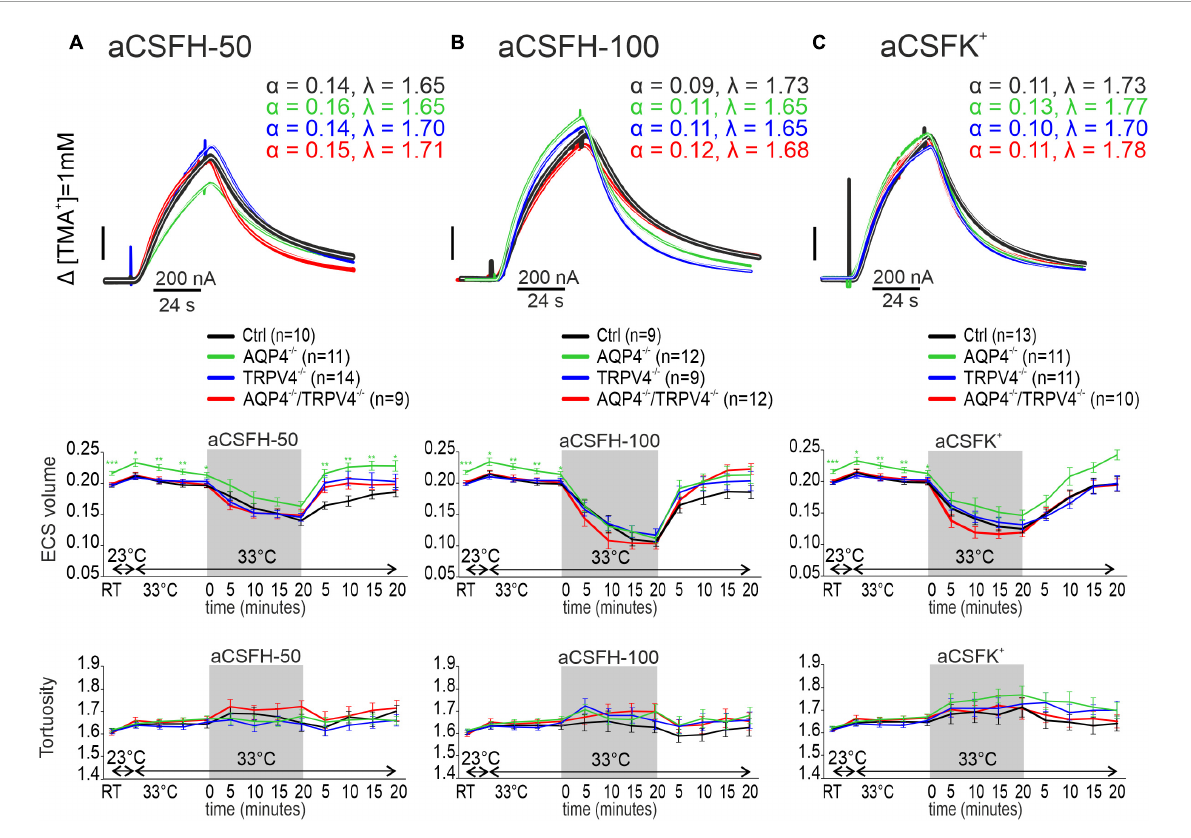
FIGURE4 The effect of hypoosmotic stress (A,B) and hyperkalemia (C) on the ECS diffusion parameters in situ . Representative diffusion curves with the corresponding values of the ECS volume fraction ( α ) and tortuosity ( λ ) recorded in the Ctrl, AQP4 − / − , TRPV4 − / − , and AQP4 − / − /TRPV4 − / − mice (upper panels). Averaged data of α (middle panels) and λ (bottom panels) measured in the Ctrl, AQP4 − / − , TRPV4 − / − , and AQP4 − / − /TRPV4 − / − mice at resting conditions (22–24 ◦ C), 33 ◦ C and at 5-min intervals during and after (washout) applications of aCSF H − 50 , aCSF H − 100 , and aCSF K + solutions. Data are expressed as mean ± SEM. No significant differences were detected between the AQP4 − / − /TRPV4 − / − and control animals. Ctrl, control; AQP4 − / − , AQP4-deficient mice; TRPV4 − / − , TRPV4-deficient mice; AQP4 − / − /TRPV4 − / − , AQP4- and TRPV4-deficient